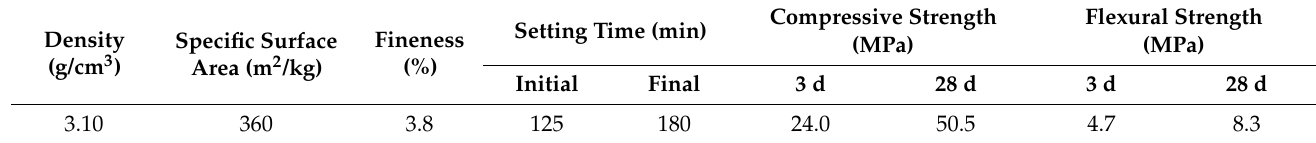
Table 2. Basic properties of cement.